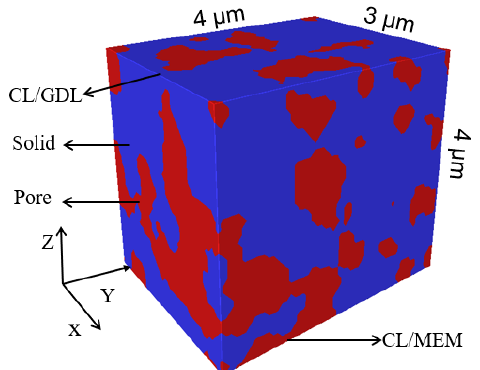
Figure 4. Geometric model of microstructure of CL.